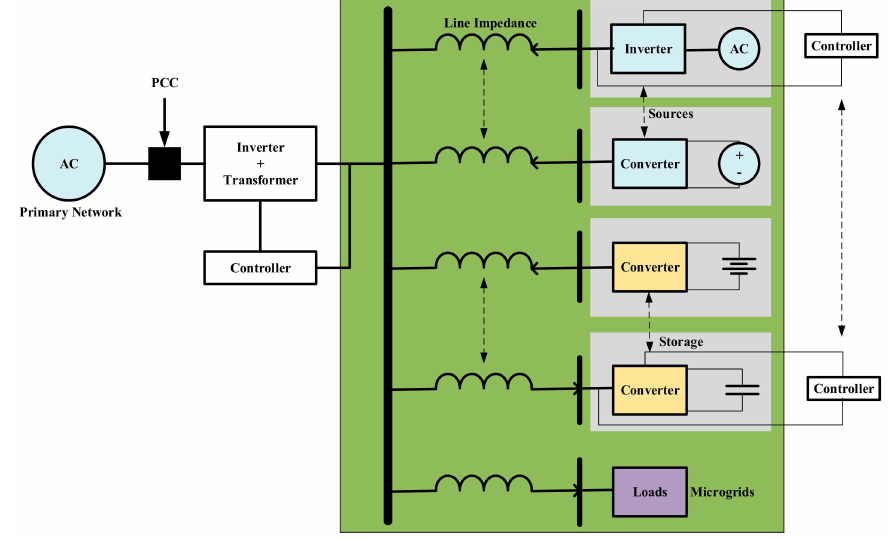
Figure 1. General structure of the